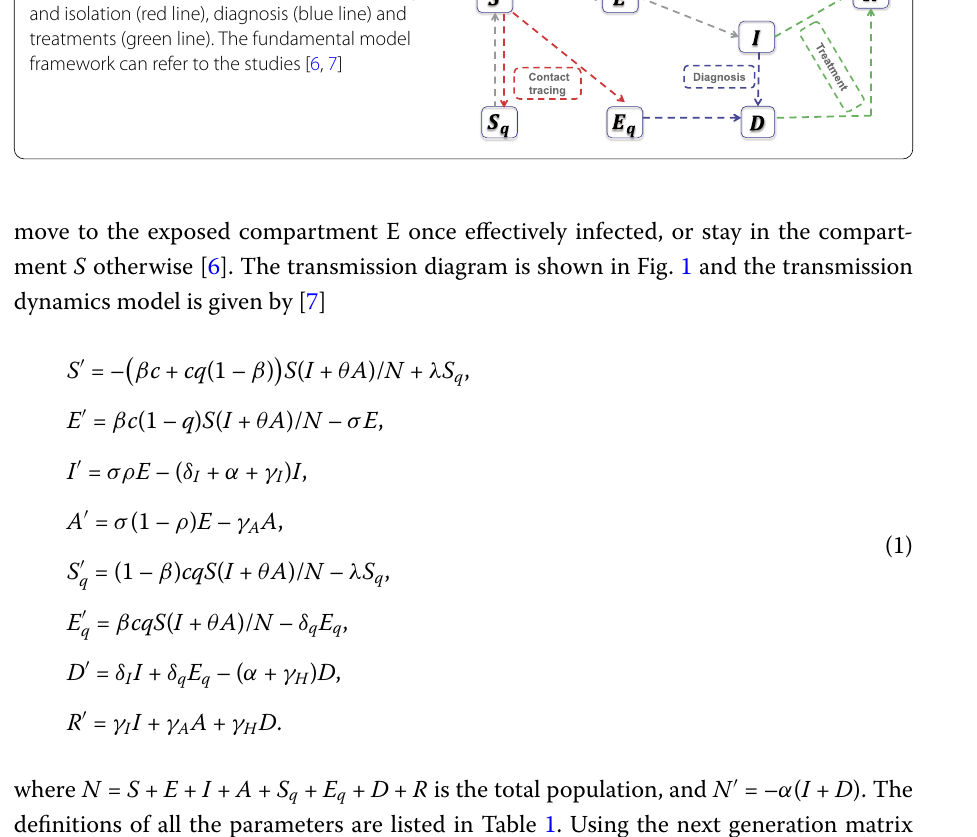
Figure 1 An illustration of the model describing the transmission of novel coronavirus (COVID-19) infection under control measures-contact tracing and isolation (red line), diagnosis (blue line) and treatments (green line). The fundamental model framework can refer to the studies [6, 7]